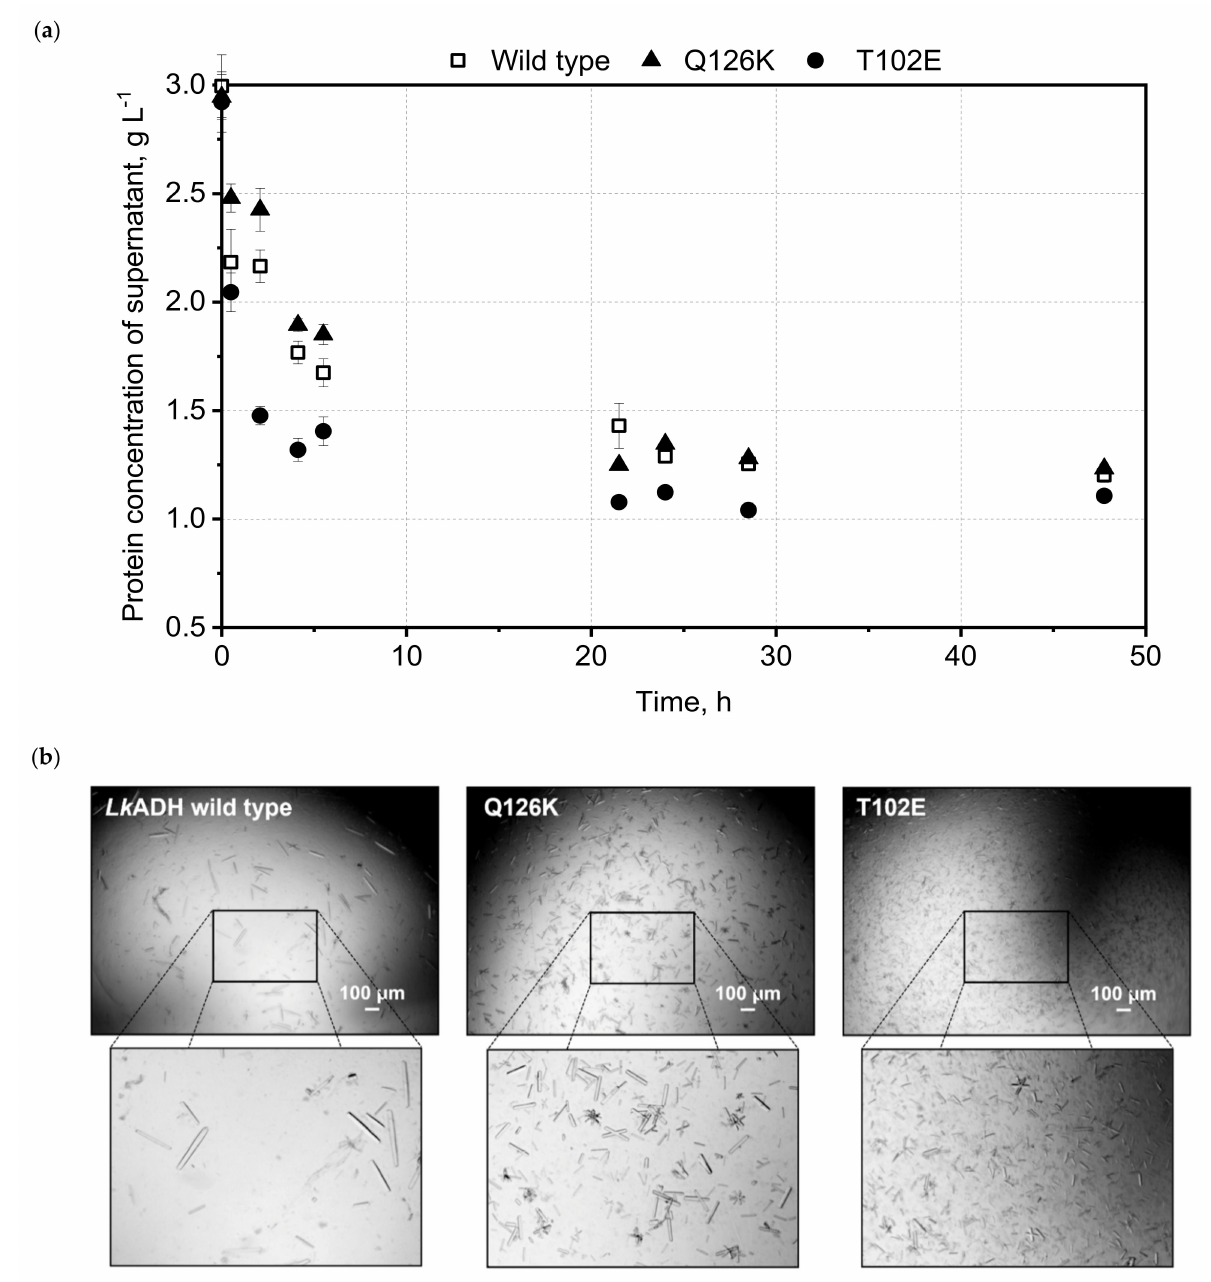
Figure 3. ( a ) Protein concentrations of clarified and dialyzed E. coli cell lysates of Lk ADH wild type and mutants T102E and Q126K. Batch crystallization was conducted in parallel stirred tank reactors (V = 5 mL, n Stirrer = 150 rpm, 20 ◦ C, 100 g L − 1 PEG MME 550). Protein concentration of supernatant was determined by BCA assay (n = 3); ( b ) Photomicrographs of Lk ADH wild type and mutants Q126K and T102E after 48 h of crystallization from clarified and dialyzed E. coli cell lysate in stirred tank reactors (c 0 = 3 g L − 1 , V = 5 mL, n Stirrer = 150 rpm, 20 ◦ C, 100 g L − 1 PEG MME